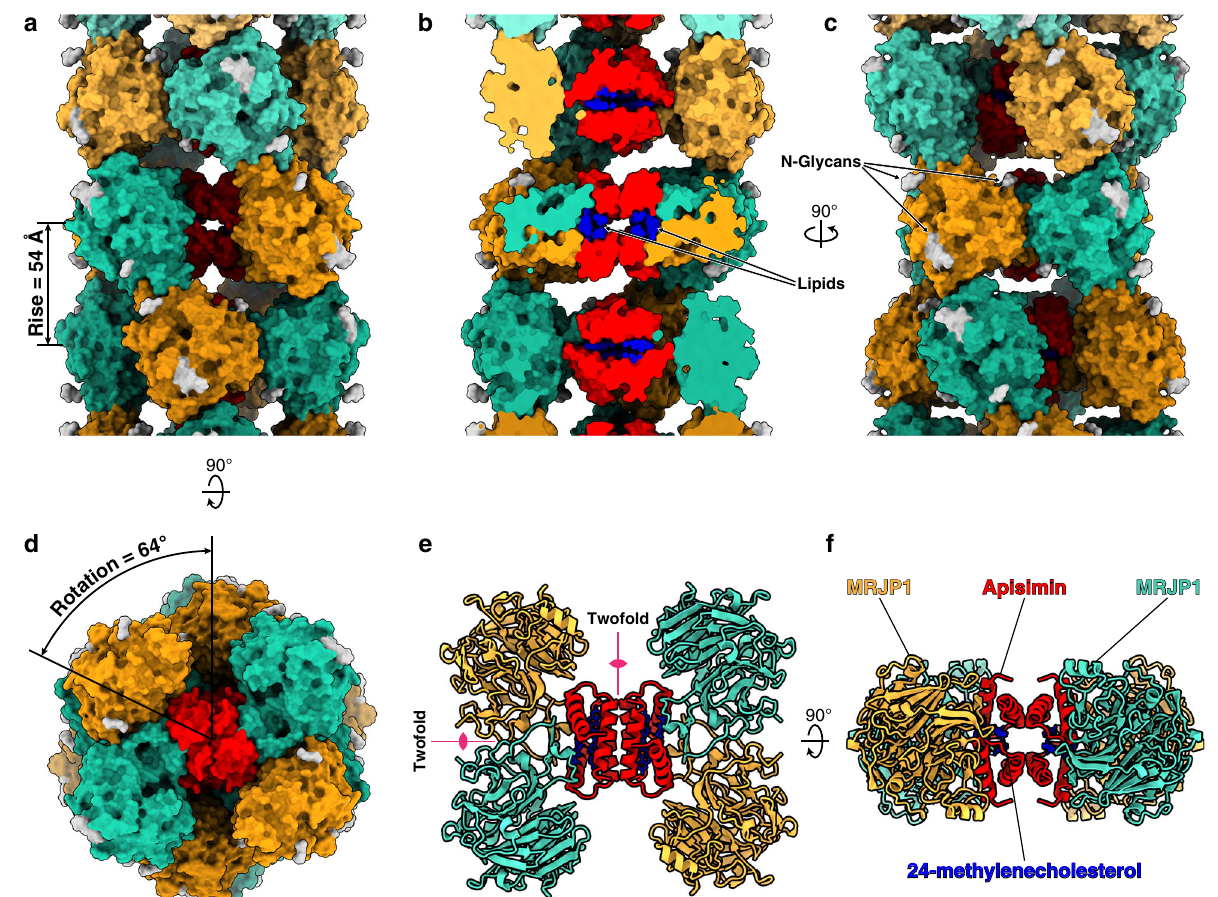
Fig. 1 Architectural overview of the native RJ fi laments. a – d The native RJ helical assembly is shown as surface representation. a Side view, the helical rise is shown. b Cross section along the longitudinal axis. c As in a after 90° rotation along the longitudinal axis. d Top view, the helical rotation is shown. The MRJP1 subunits in each MRJP 4 -apimisin 4 hetero-octamer layer are alternately colored in orange and cyan to distinguish subunits from different layers. Apisimin is colored in red, 24-methylenecholesterol in blue, and N-glycans in silver. e , f The H-shaped MRJP1 4 /apisimin 4 /24-methylenecholesterol 8 complex is shown from two orthogonal orientations with proteins represented as ribbons and the lipids as sticks. e Top view with the two 2-fold symmetry axes indicated as pink lines. f Side view along one of the 2-fold